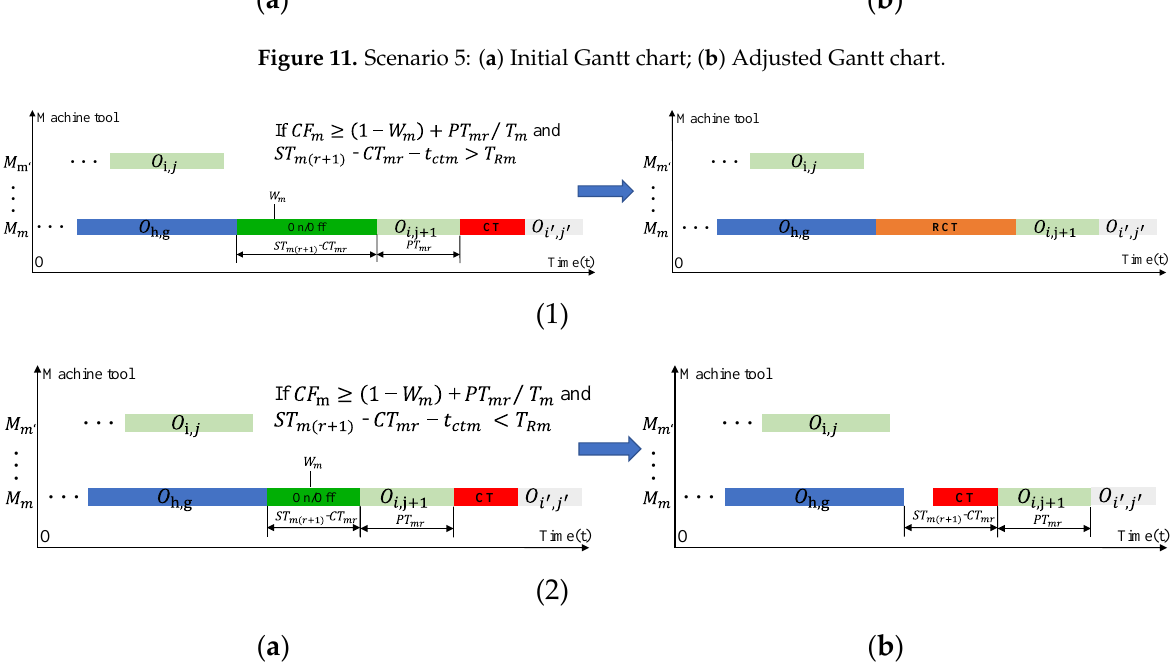
Figure 11. Scenario 5: ( a ) Initial Gantt chart; ( b ) Adjusted Gantt chart.